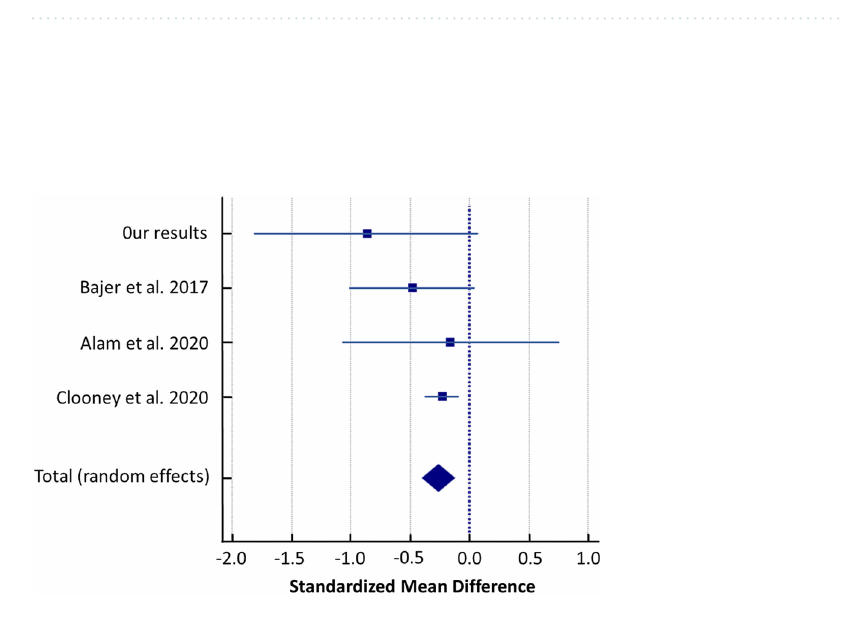
Figure 11. Forest plot of random-effects meta-analysis including studies evaluating the abundance of Streptococcus in UC patients versus healthy controls.